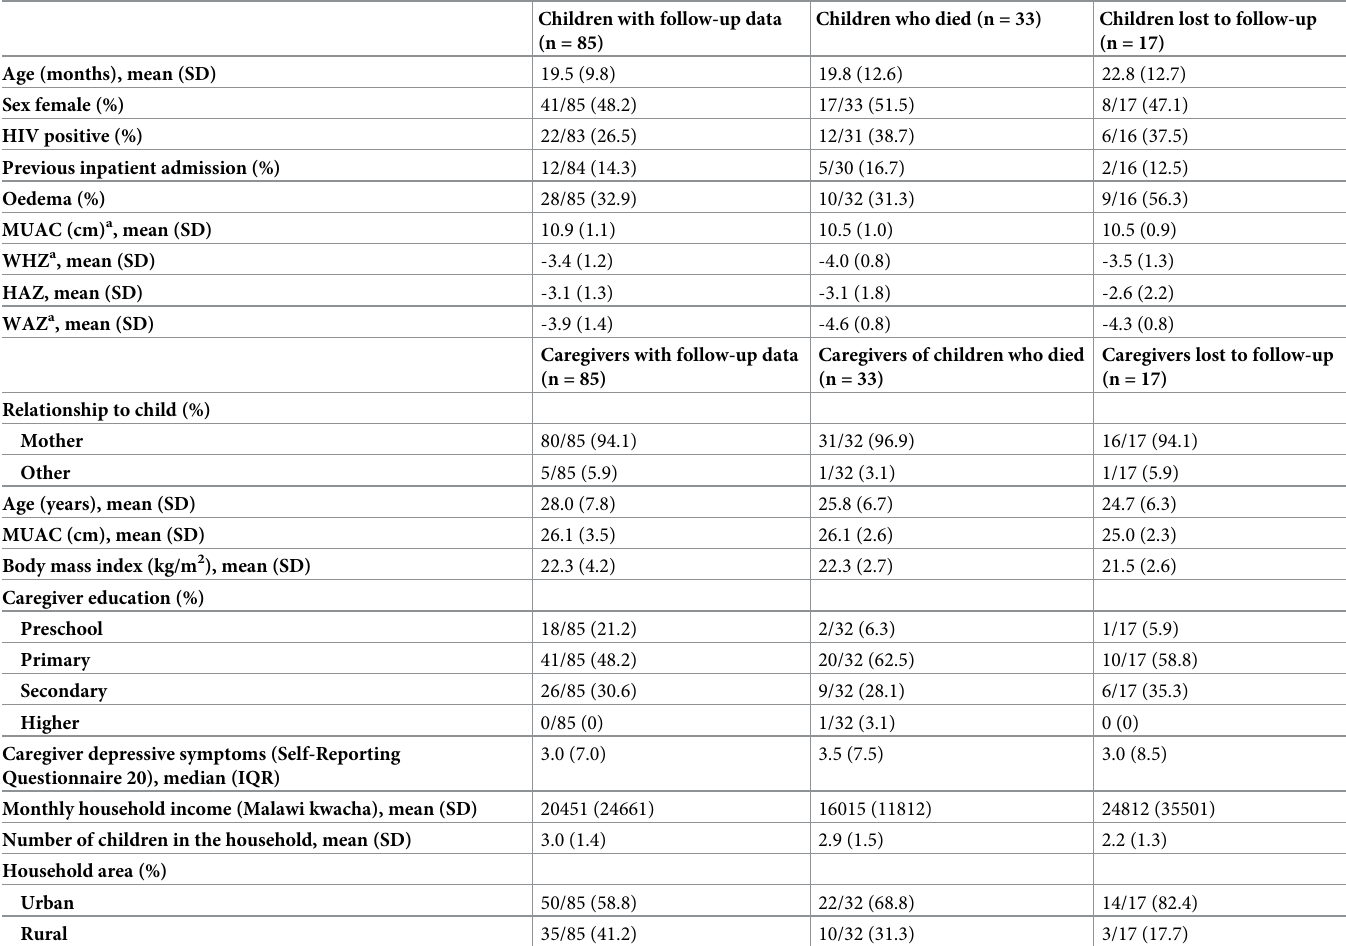
Table 1. Baseline characteristics of children admitted for inpatient treatment of SAM and their caregivers and